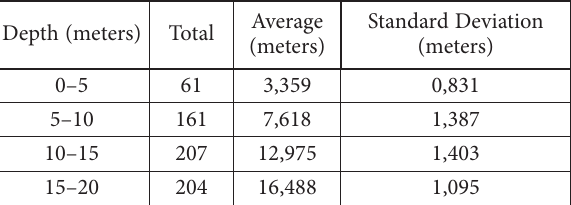
Table 2. The sample depth in this research